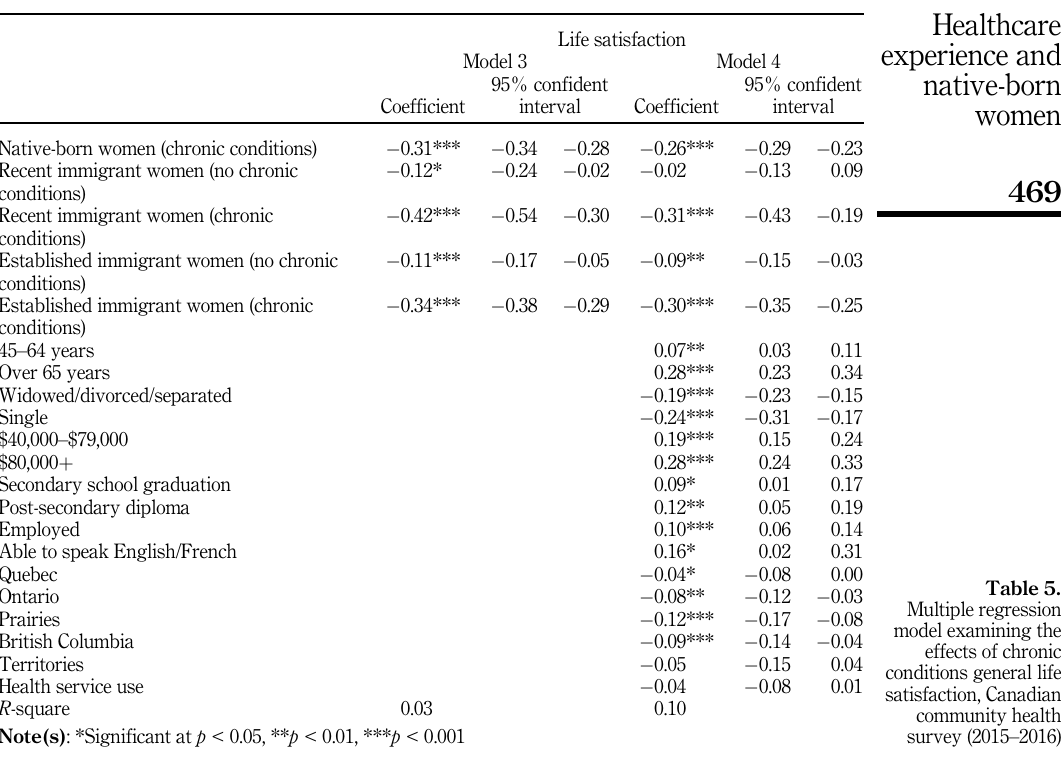
Table 5. Multiple